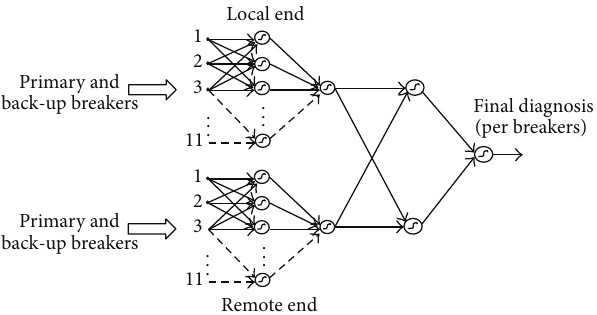
Figure 2: Modular network for the fault diagnosis by breakers in the